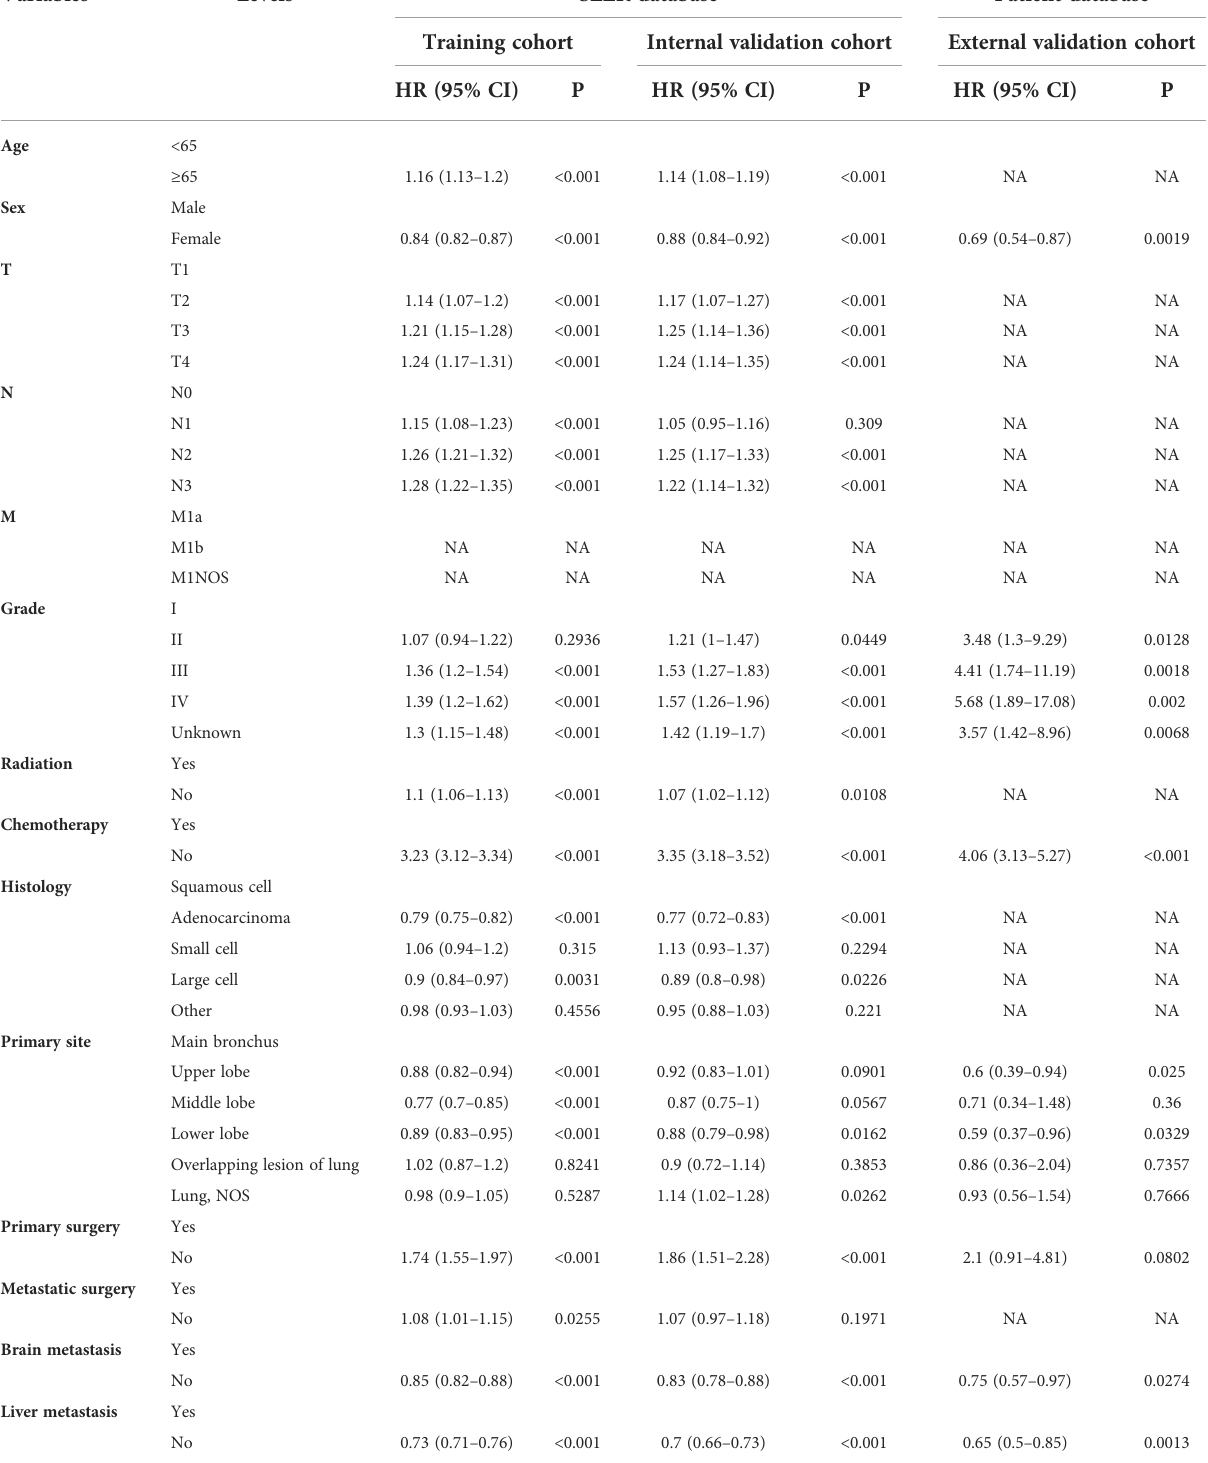
TABLE 5 Multivariate Cox regression model in the training, internal validation, and external validation cohorts of cancer-speci fi c survival (CSS) (N,